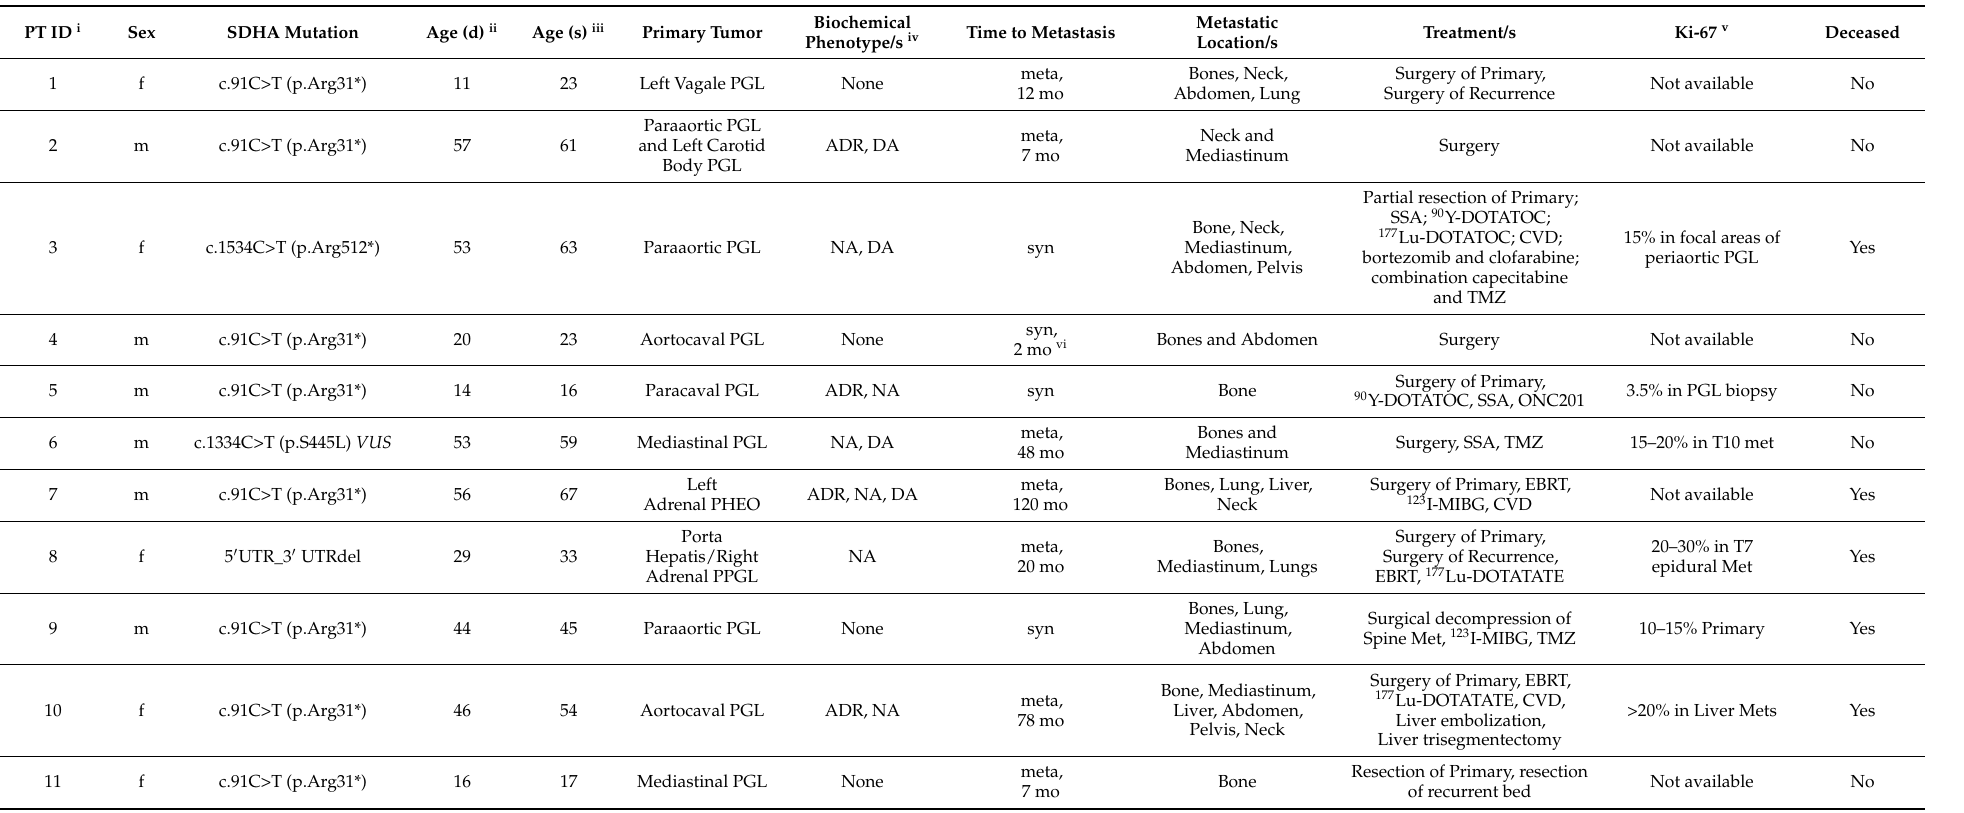
Table 1. Clinical Characteristics of SDHA Patients in the